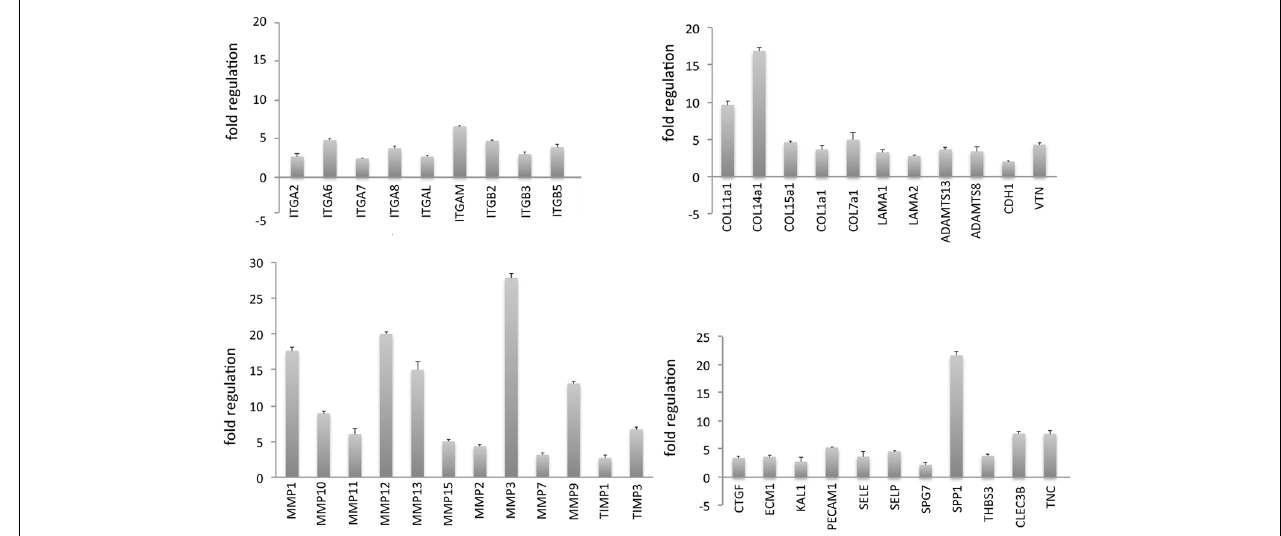
FIGURE 3 | Three-dimensional (3D) stem cell culture induces a significant remodeling in the expression of genes involved in cell adhesion and ECM deposition. Human cardiac progenitor cells (hCMPCs) were grown for